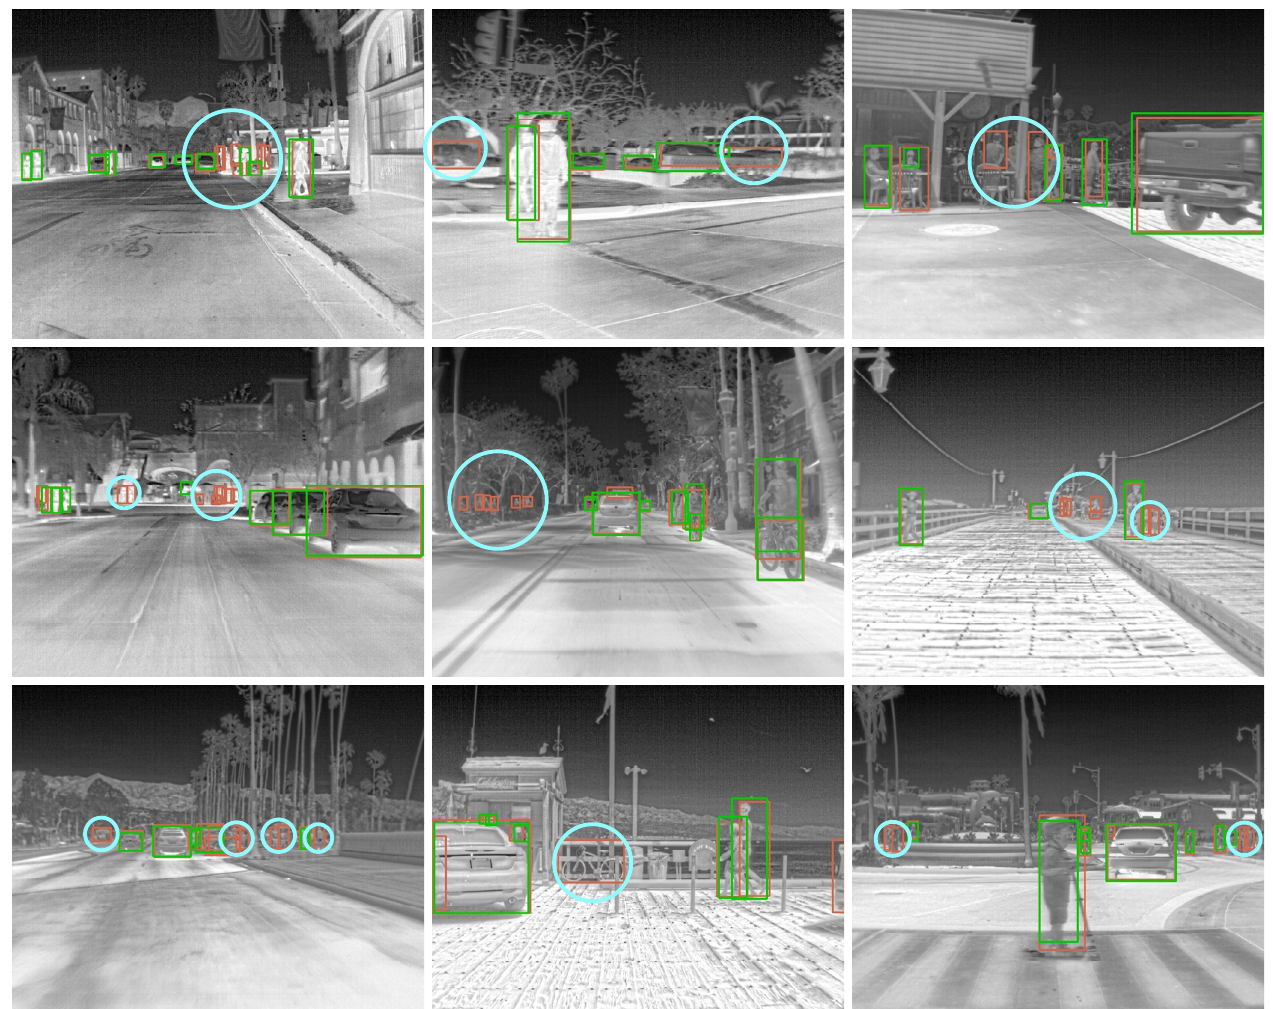
Figure 6. Our method detects results on some typical images in the FLIR dataset. The prediction box of the baseline is marked as green, and the prediction box of the proposed method is marked as orange-red.